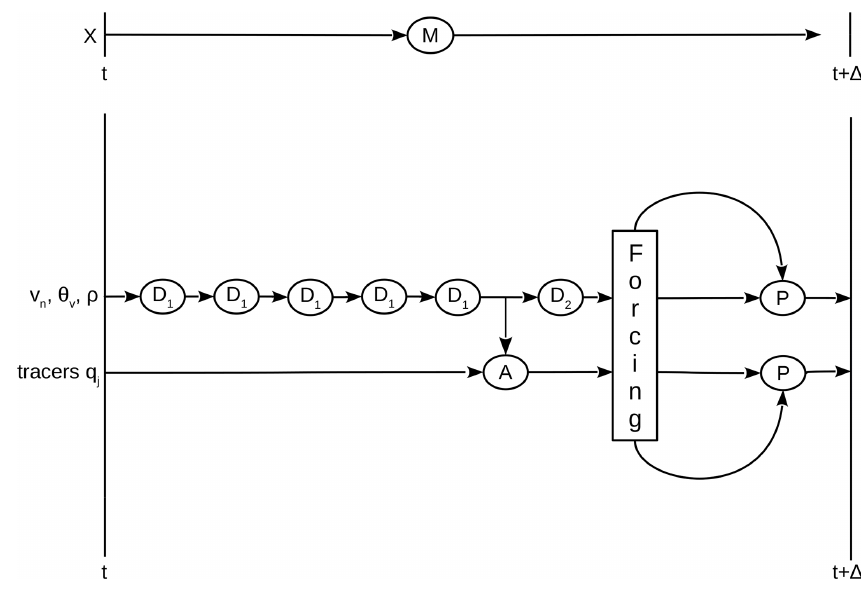
Figure 2. The model operator M propagates the model state X from time t to t + d t , with X consisting of the variables v n ,θ v and ρ , which are processed by the dynamics, and tracer mass fractions q i , which are processed by the advection scheme A . The dynamics consists of a sequence of five sub-steps ( D 1 ), each propagating the dynamics variables by d t/ 5, followed by horizontal diffusion ( D 2 ). The advection makes use of the air mass flux computed in the dynamics to achieve consistency with continuity. The intermediate state resulting from dynamics and advection is used for the computation of the forcing, which is applied in the physics update (P) that produces the new state X(t + d t) . Table 1. System software used for compiling ICON on Piz Daint, JUWELS Booster, and Levante. Software Piz Daint JUWELS Booster Levante Compiler